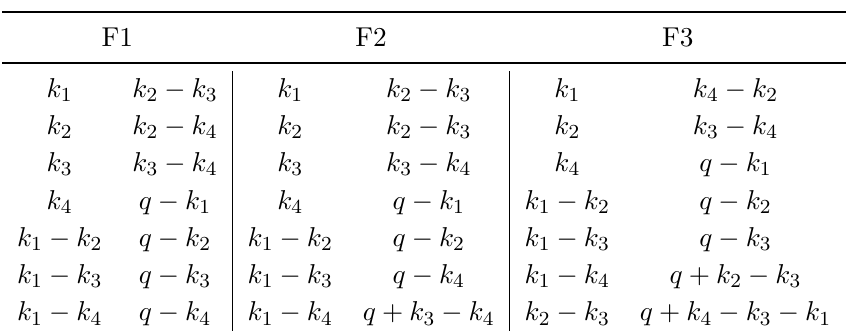
Figure 1 . Example of a four-loop massless photon self-energy featuring three internal gluons with different possible choices of cut propagators (in red). According to the number of propagators on cut, the same diagram can represent the integral over the phase space of: (a) a tree-level squared amplitude γ → qggg ¯ q , (b) the interference between a one-loop amplitude γ → qgg ¯ q with its tree-level, (c) the interference between a two-loop amplitude γ → qg ¯ q with its tree-level, (d) the interference between a three-loop amplitude γ → q ¯ q with its tree-level.